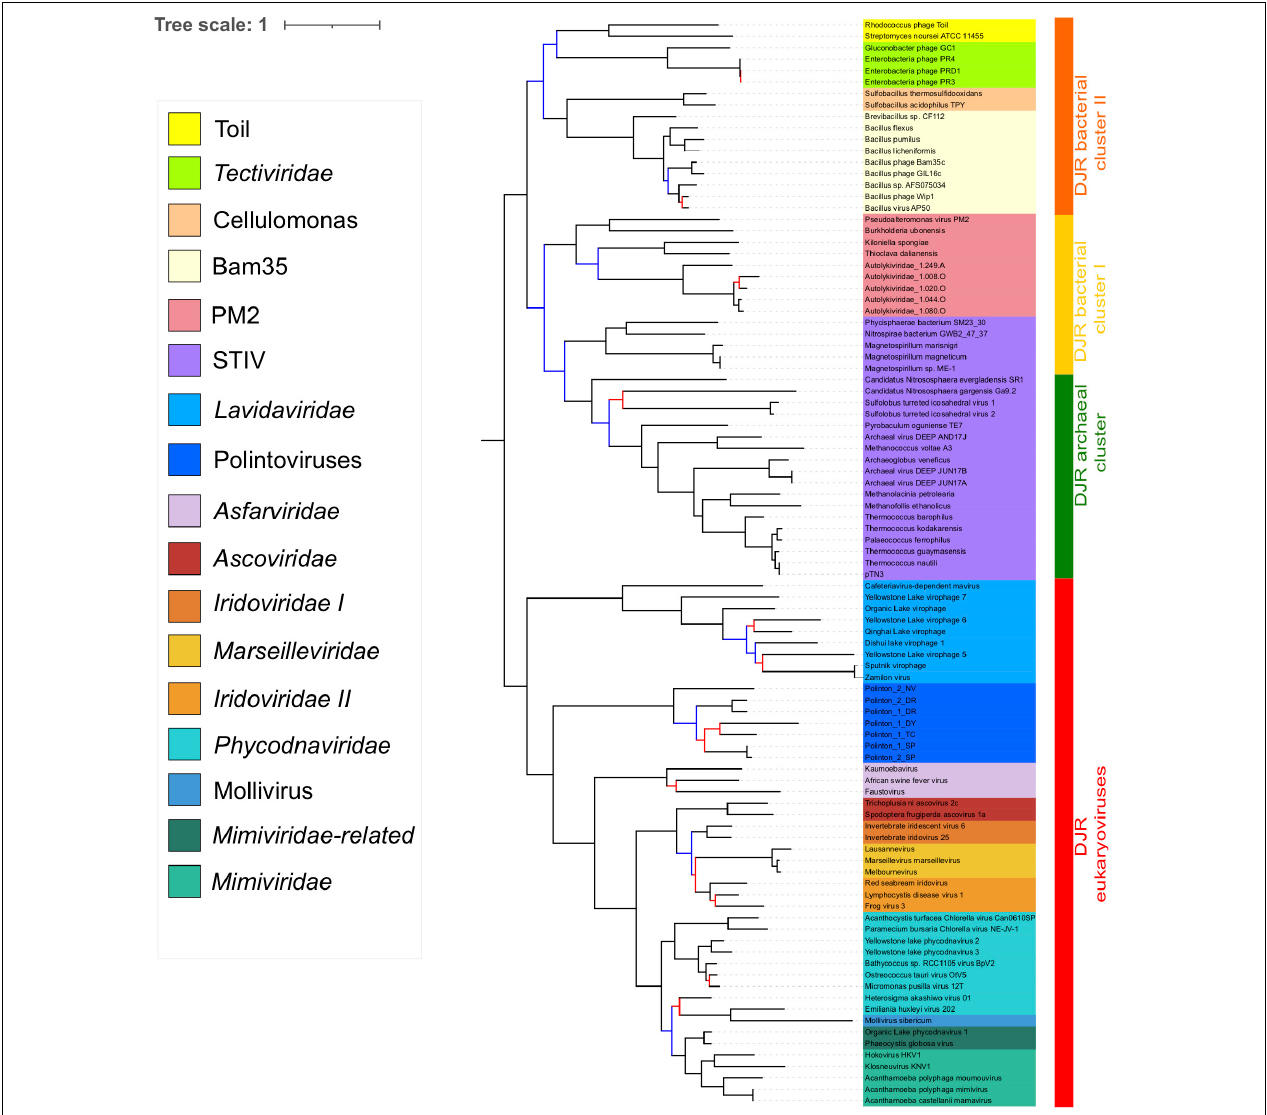
FIGURE 4 | Phylogenetic tree of the concatenated major capsid protein and packaging ATPase genes, excluding the Poxviridae . The alignment has 95 sequences with 434 positions. Phylogenetic tree was rooted between the prokaryotic and eukaryotic members. The scale-bar indicates the average number of substitutions per site. The best-fit model was LG + F + R5, which was chosen according to Bayesian Information Criterion (BIC). Branches in black indicate both classical bootstrap and transfer bootstrap expectation (TBE) support values using 1,000 replicates are above 70%. Branches in blue indicate only one of the two support values is above 70% whereas branches in red indicate both support values are below